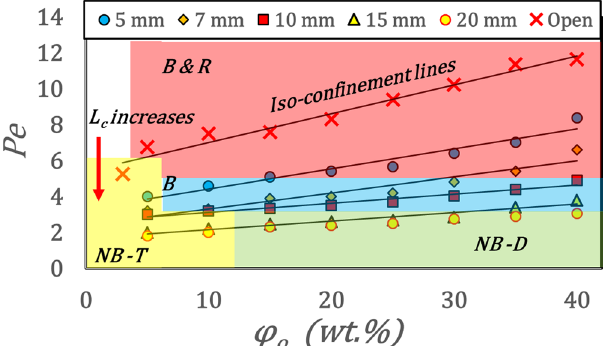
Figure 6. Regime map showing various final droplet morphologies for confined (different L c ) and unconfined cases at different ϕ o . Notations used are B & R–Buckling and rupturing, B–Only buckling, NB-D–no buckling with dome shape and NB-T–No buckling with disc